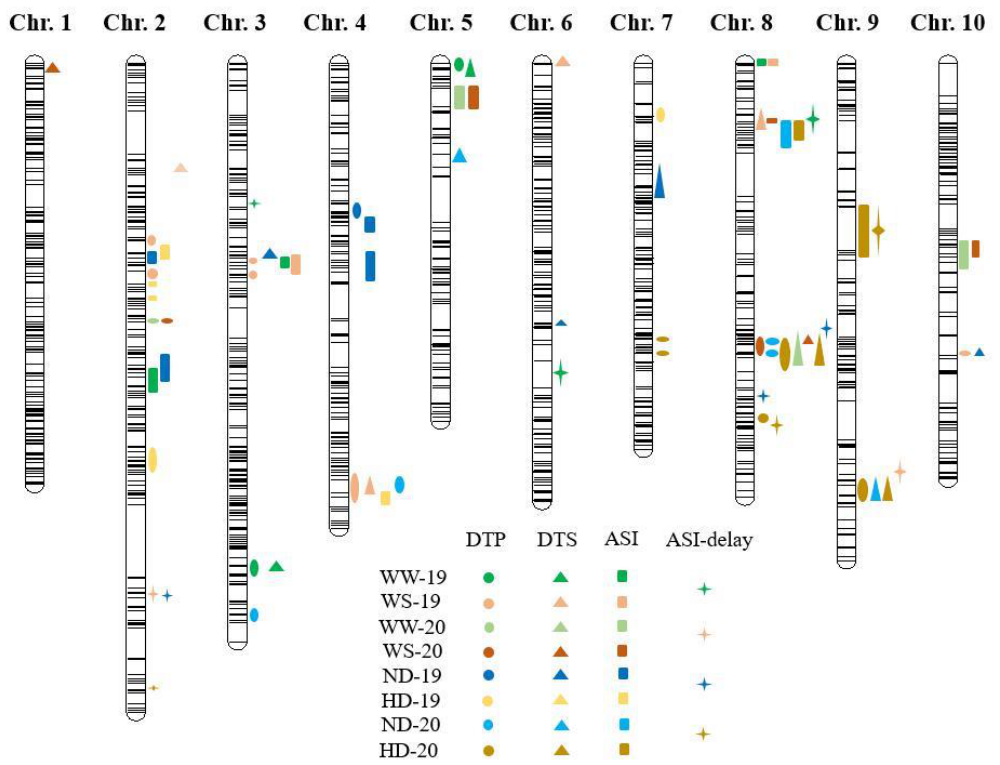
Figure 2. QTL for days to anthesis (DTA); days to silking (DTS); anthesis-silking interval (ASI); and ASI-delay evaluated under well-water (WW); water-stress (WS); normal density (ND); and high density (HD). Circles, triangles, squares, and masks represent the DTA, DTS, ASI, and ASI-Delay, respectively.